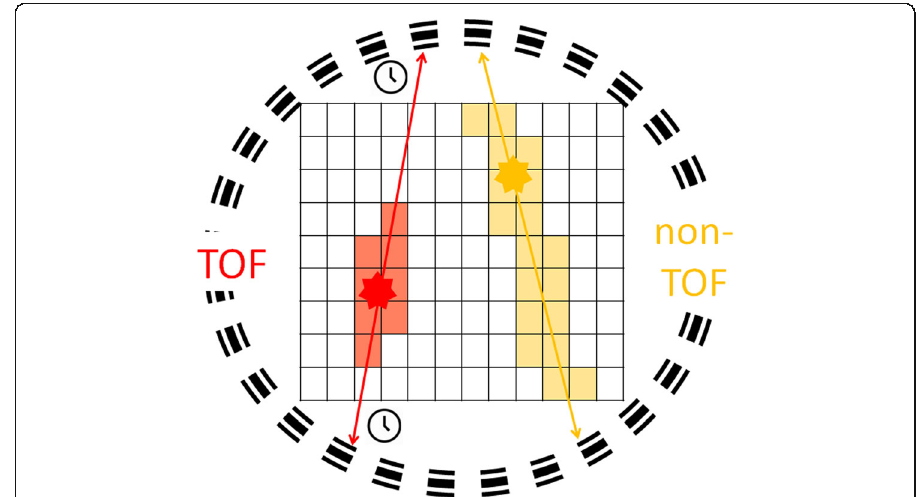
Fig. 7 Schematic drawing of the basic principle of time-of-flight (TOF) PET. Annihilation events are marked as stars and the line of response as double-headed arrows. In conventional PET (non-TOF, yellow), the location of the annihilation event cannot be further located on the line of response and can only be deducted by reconstruction. In TOF PET (TOF, red), the time difference between the detection of both γ -rays is recorded, allowing for an estimation of the location of the annihilation event and resulting in a higher signal-to-noise